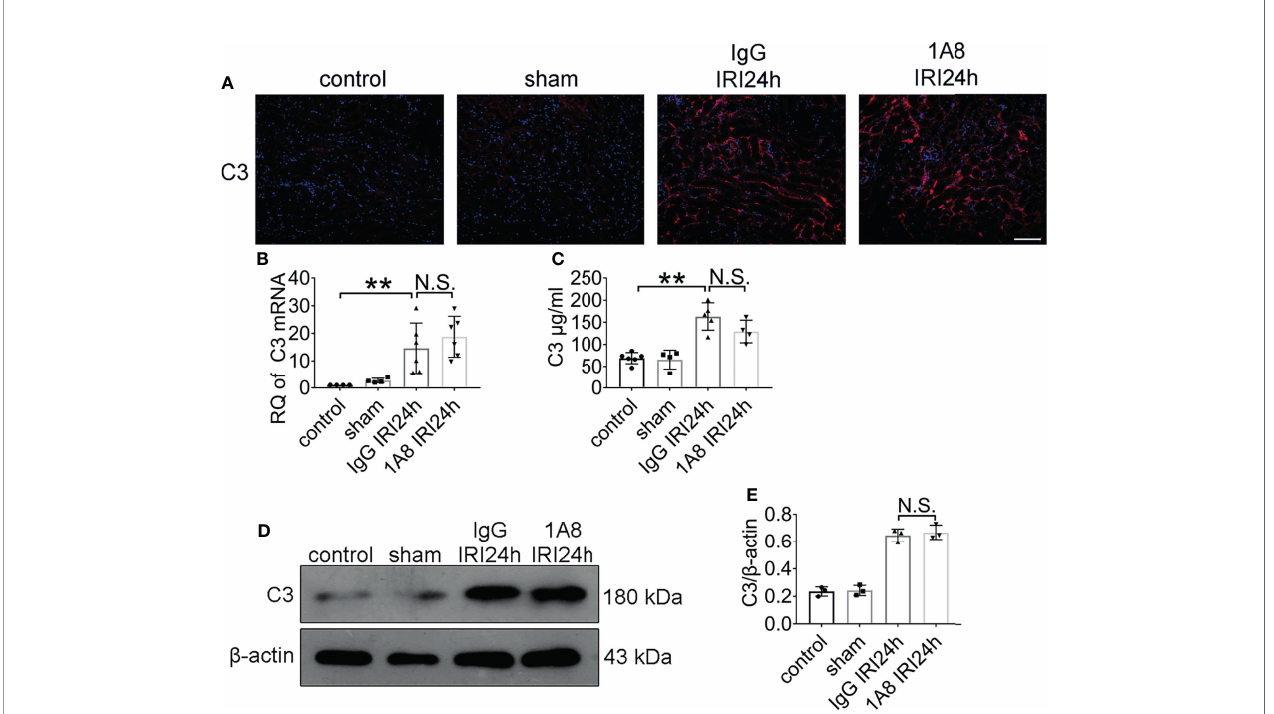
FIGURE 6 | The expression of C3 did not change after neutrophil depletion. Levels of C3 in sham-operated mice and bilateral IRI kidneys in 1A8 and IgG mice (ischemia for 45 min and reperfusion for 24 h) were measured by IF (A) , qPCR (B) , and ELISA (C) , n = 4 – 6/group. (D) Immunoblotting analysis of C3 (expected weight: 180 kDa) expression in 1A8 and IgG mouse kidneys 24 h after IRI. (E) Quantitative analysis was analyzed by normalization to b -actin expression, n = 3/ group. **P < 0.01. N.S., No Signi fi cance. Data are presented as mean ±